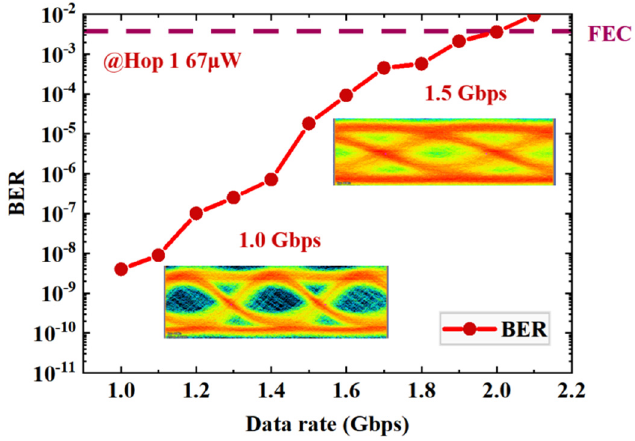
Figure 7. Measurement of real-time BER with OOK format from Hop 1. (Inset: the corresponding eye diagrams at the data rates of 1.0 Gbps and 1.5 Gbps.)